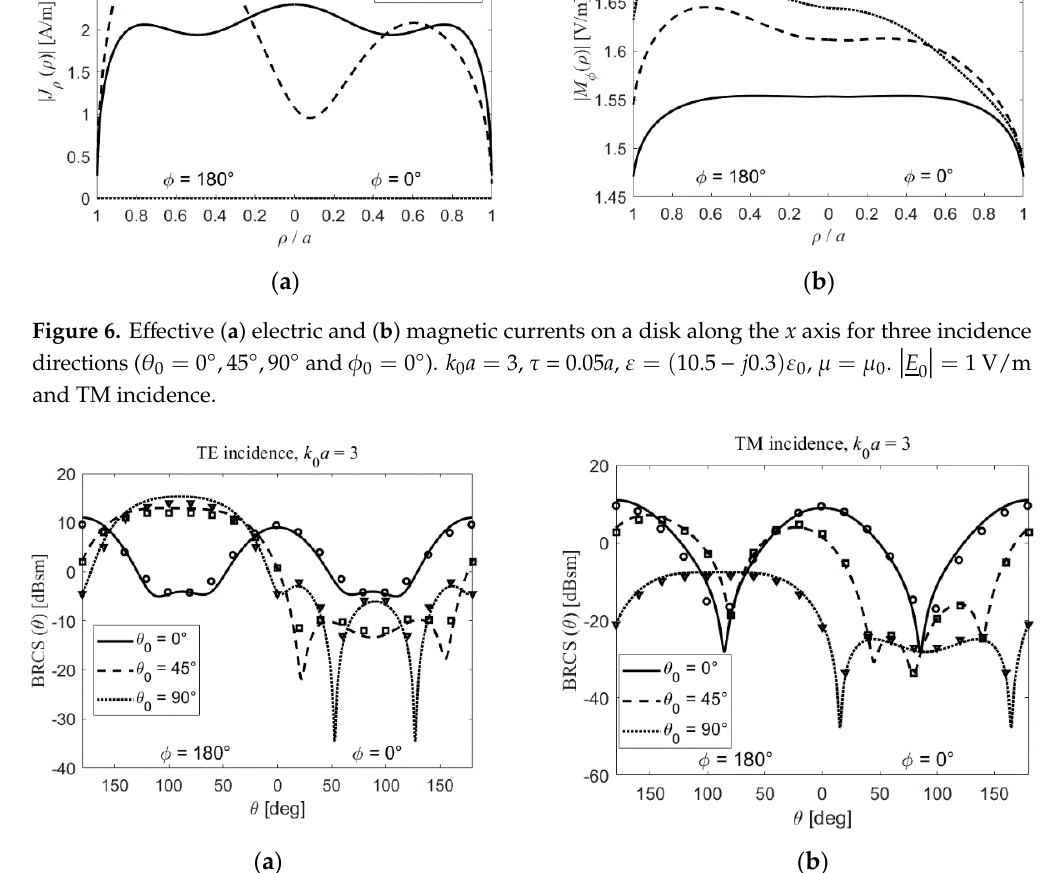
0 ,45 ,90 θ = ° ° ° and 0